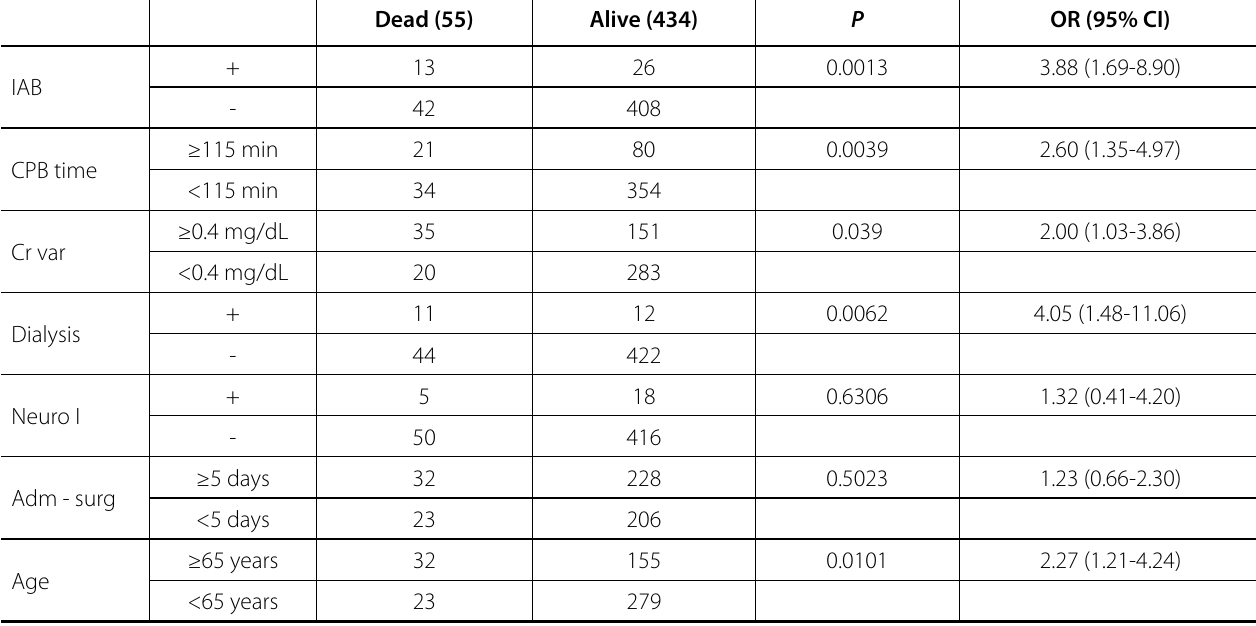
Table 4 . Mortality risk factors among ONCABG patients (n=489) with admission creatinine levels greater than or equal to 1.4 and less than 2.6 mg/dL